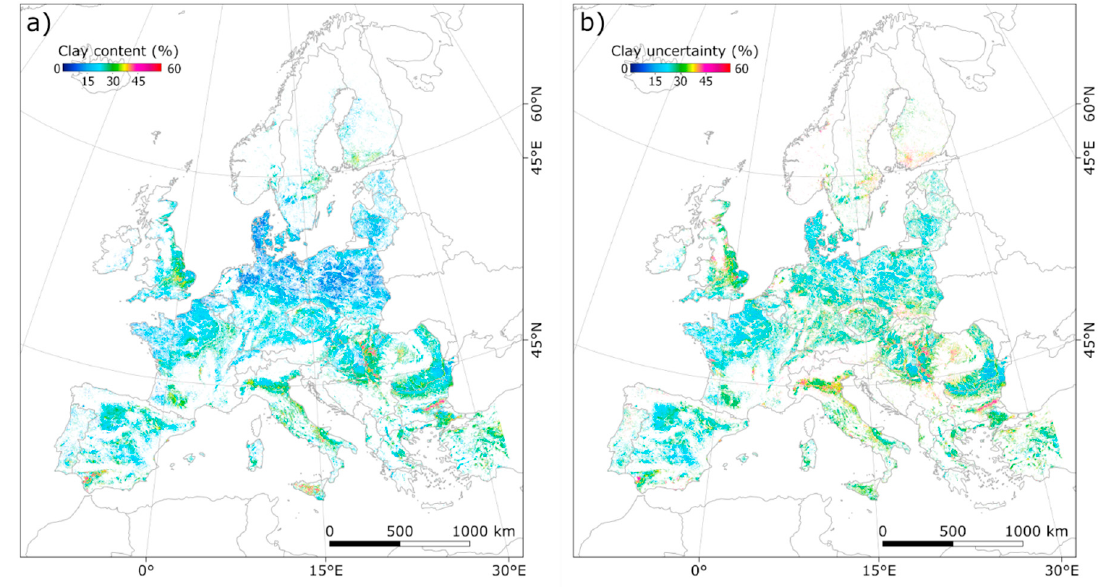
Figure 3. ( a ) Soil European clay map using the full synthetic soil image (SYSI) as model predictor; ( b ) the clay uncertainty map.